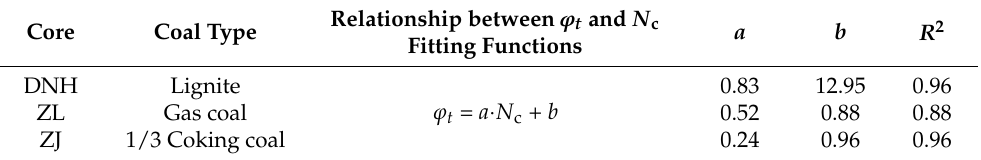
Figure 8. Variation in the total porosity φ t of the three coal cores. Table 2. Parameters of fitting functions between the total porosity and cycle numbers for three coal